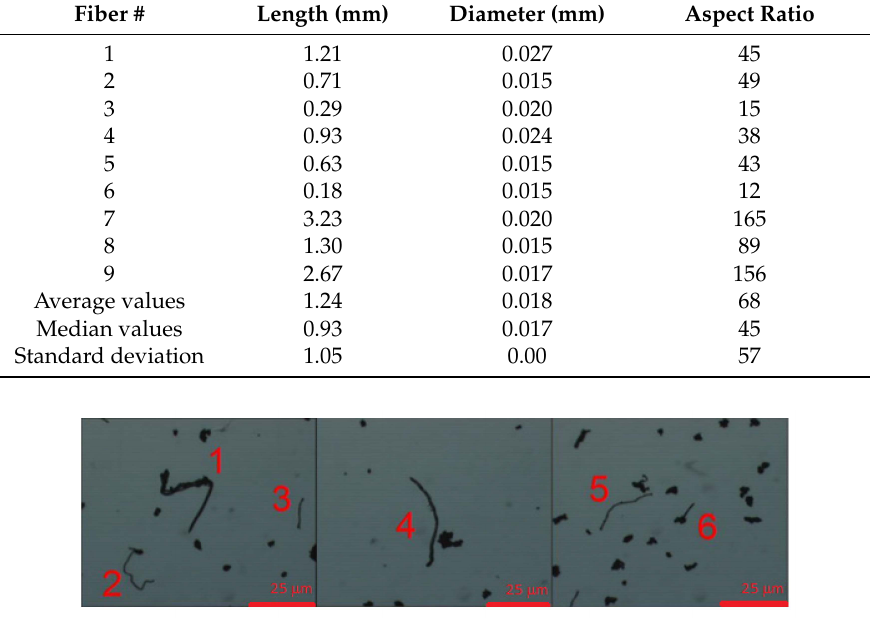
Figure 4. Size of short isolated fibers labeled according Table